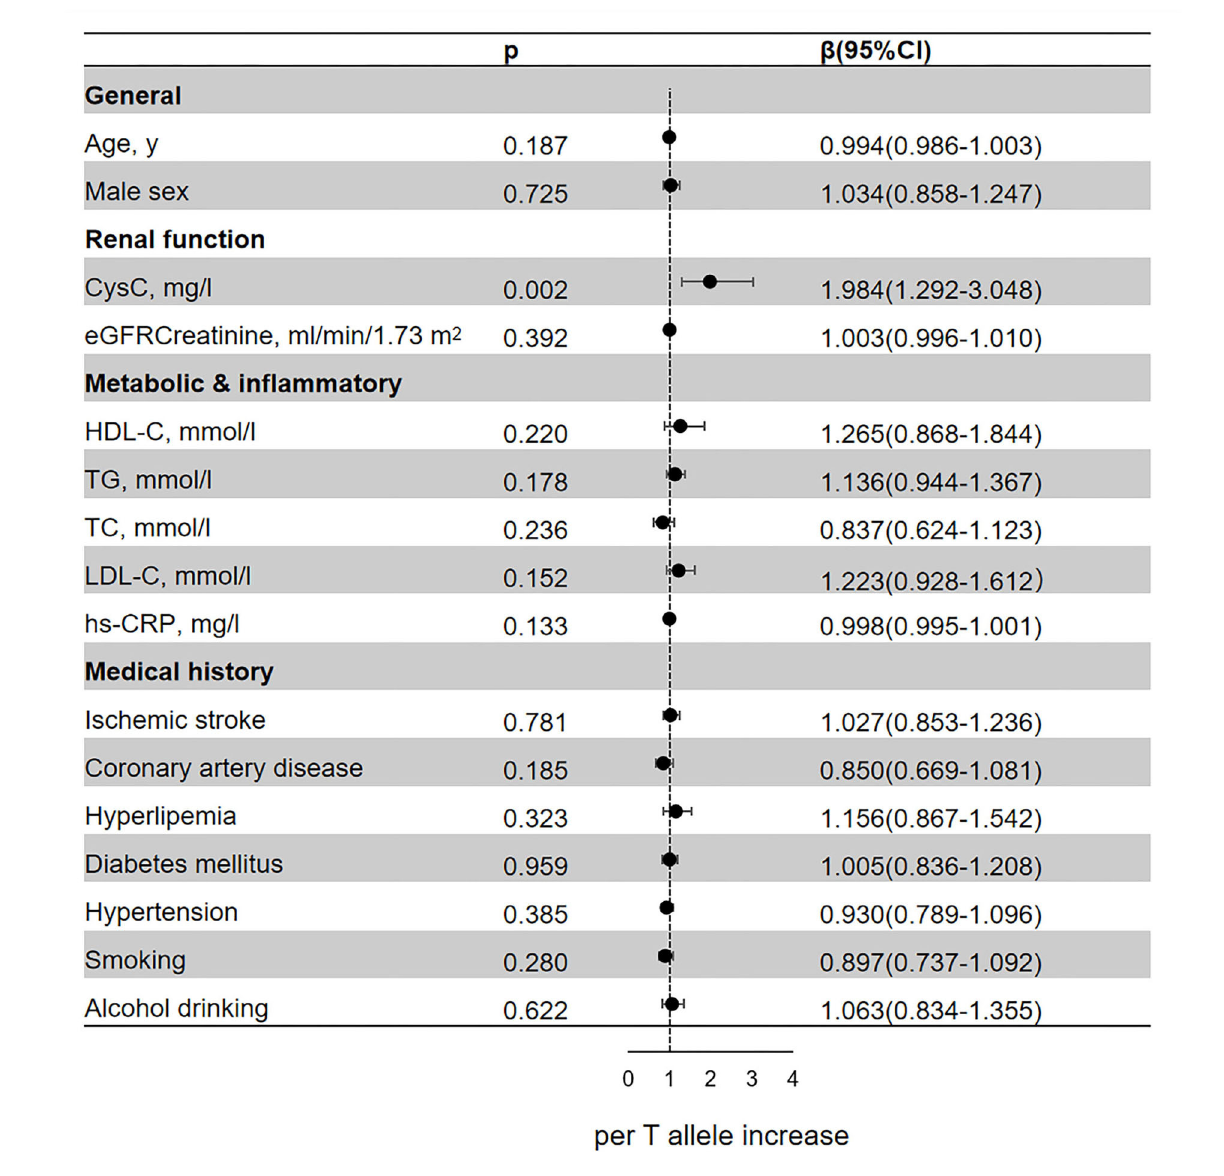
FIGURE 3 | Association of the genetic variant (rs911119 polymorphisms) with cardiovascular risk factors and traits. Effect sizes ( β ) are presented as standard deviations of each trait per major allele to facilitate comparison between traits. Adjusted for age, sex, CysC, eGFRcr, HDL-C, TG, TC, LDL-C, hs-CRP, smoking, alcohol drinking, ischemic stroke, coronary artery disease, hyperlipidemia, diabetes mellitus, and hypertension. BMI, body mass index; CysC, cystatin C; eGFRcr, creatinine-based estimated glomerular filtration rate; LDL, low-density lipoprotein; HDL, high-density lipoprotein; TG triglyceride; TC, total cholesterol; hs-CRP, high-sensitivity C-reactive protein; CI, confidence